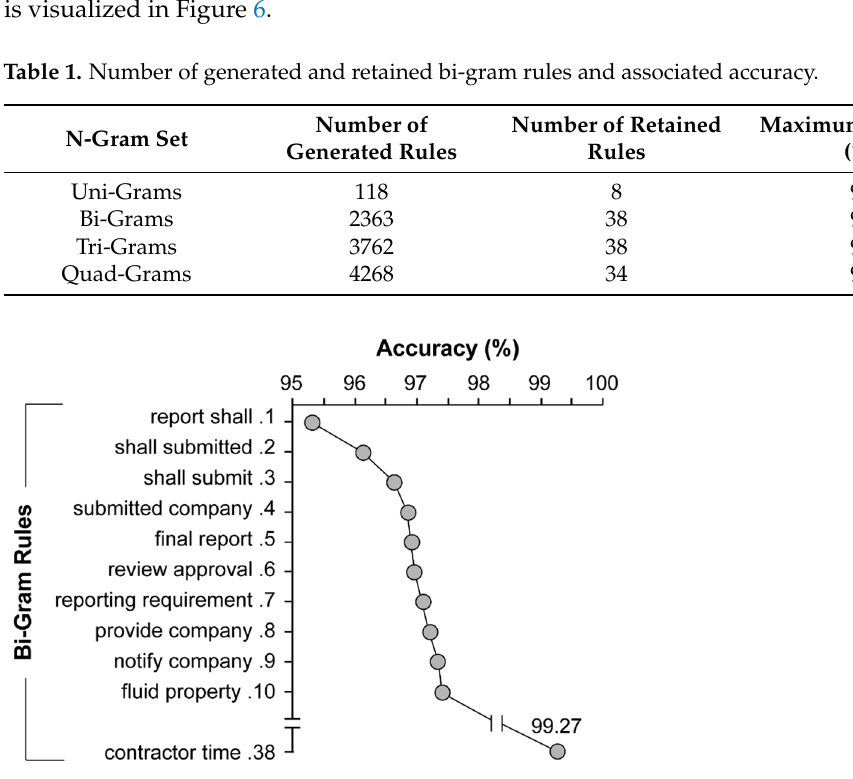
Figure 6. Impact of adding bi-gram rules on the accuracy of the rule-based text classifier.